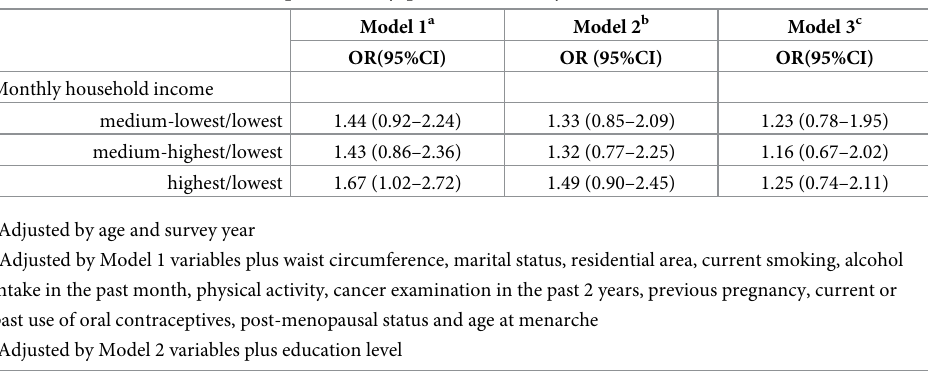
Table 4. The ORs for breast cancer prevalence by quartile of monthly household